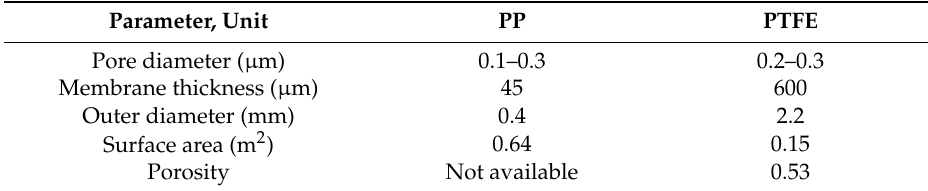
Table 1. Structural parameters of the polypropylene (PP) and polytetrafluoroethylene (PTFE) hollow fiber membranes.